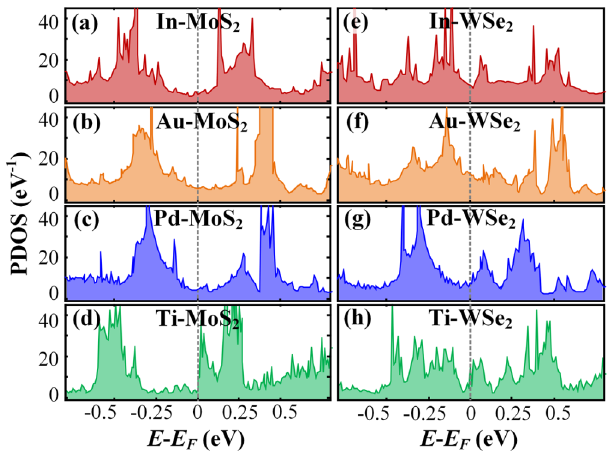
FIG. 21. (a),(b) Minimum of average electron density values in the x - y plane in Fig. 18(a) at the interfaces for all top and edge contacts. Ti, Pd, Mo, and W may form better top contacts due to higher interface electron density. Electron densities are signifi- cantly increased for edge contacts. (c),(d) Valence electron densities of Au-MoS 2 edge contact. (c) Average density along y projected on the x - z plane; (d) average density in the x - y planes normal to the z axis. The red number in (d) indicates the minimum electron density at the interface.